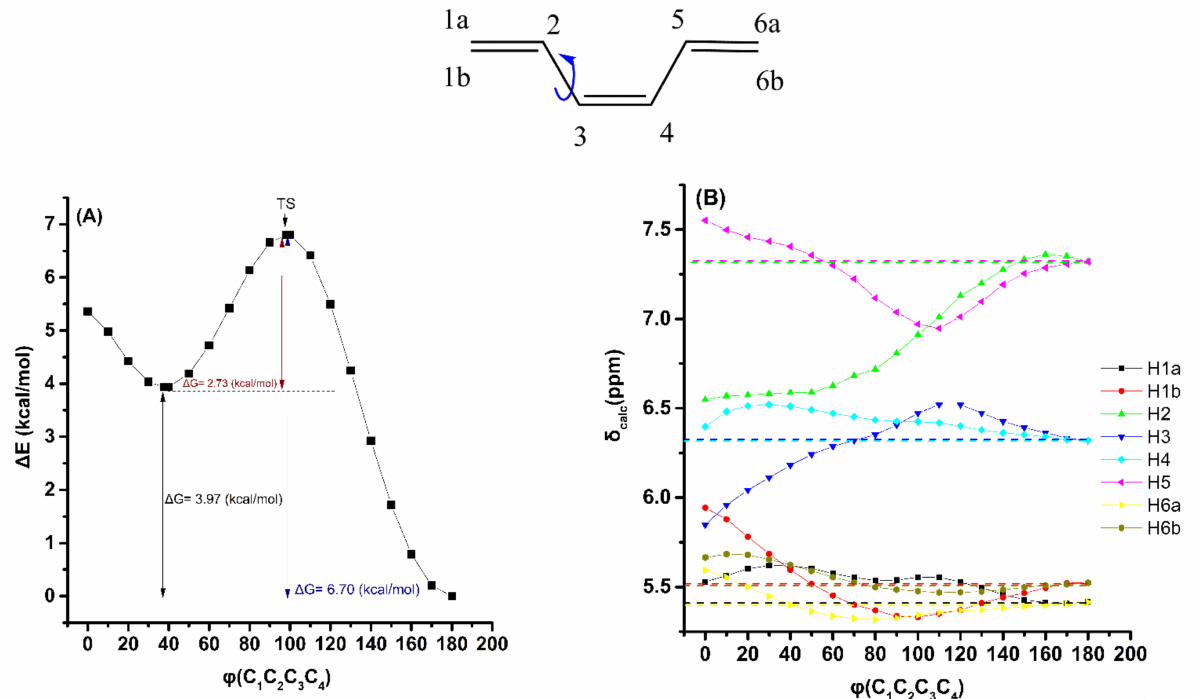
Figure 3. Effect of the variation in the torsion angle ϕ (C 1 C 2 C 3 C 4 ) of ( Z )-1,3,5-hexatriene, with energy minimization at the B3LYP/6–31+G(d) level, on the electronic energy ∆ E (kcal/mol) (characteristic ∆ G values are also shown) ( A ), and δ calc ( 1 H) data of the olefinic protons (at the GIAO/B3LYP/6–311+G(2d,p) level with CPCM in CHCl 3 ) ( B ). The experimental chemical shift values are denoted with the horizontal dotted lines.